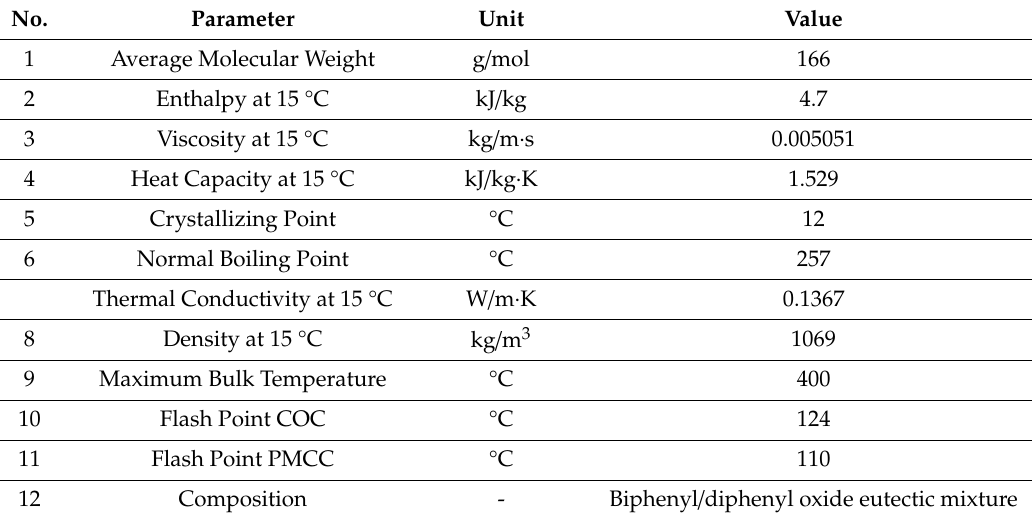
Table 4. Therminol VP-1 properties